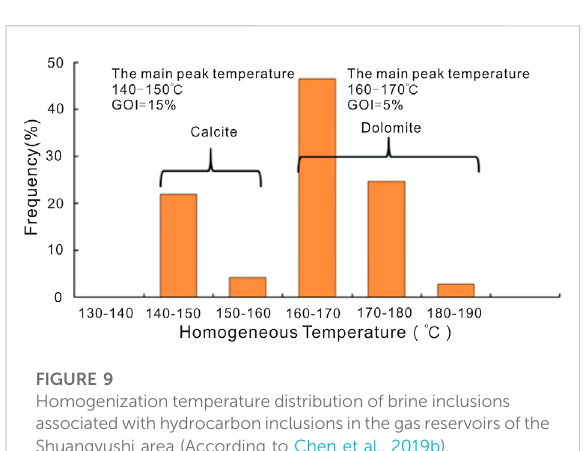
FIGURE 9 Homogenization temperature distribution of brine inclusions associated with hydrocarboninclusionsinthe gasreservoirs ofthe Shuangyushi area (According to Chen et al.,